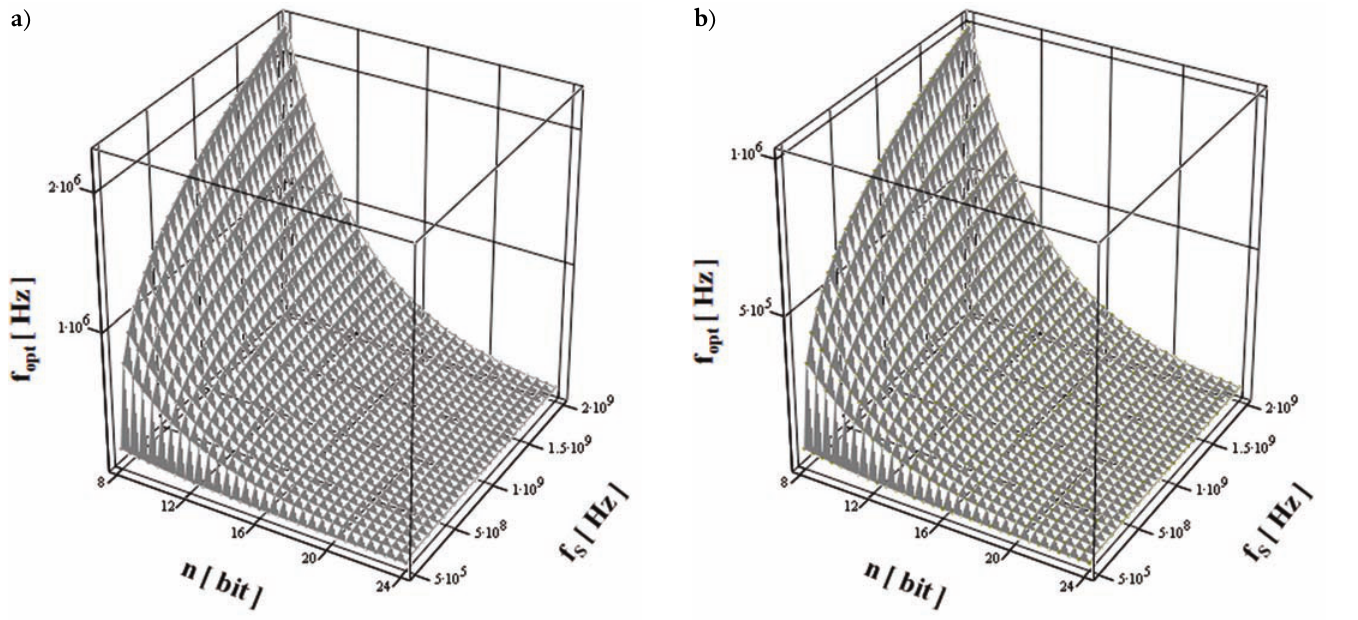
Figure 4. With reference to the operating conditions described in the caption to Figure 2 (for quadrupolar probe). Plots for the optimal working frequency f ( n , f ), which minimizes the inaccuracies in the measurements of dielectric permittivity, as functions of both the bit resolution n and the sampling rate opt,U S f , for terrestrial soil (a) and concrete (b) S